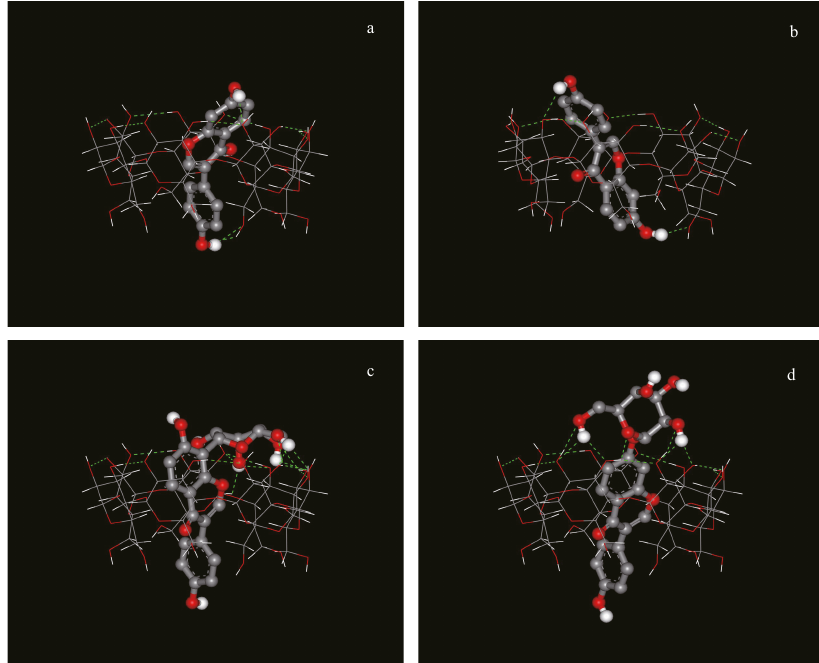
Figure 5 : Possible structure of the inclusion complex between ( a ): daidzein and β -CD, type I; ( b ): daidzein and β -CD, type II; ( c ): puerarin and β -CD; ( d ): daidzin and β -CD obtained with the program Autodock 4.0).